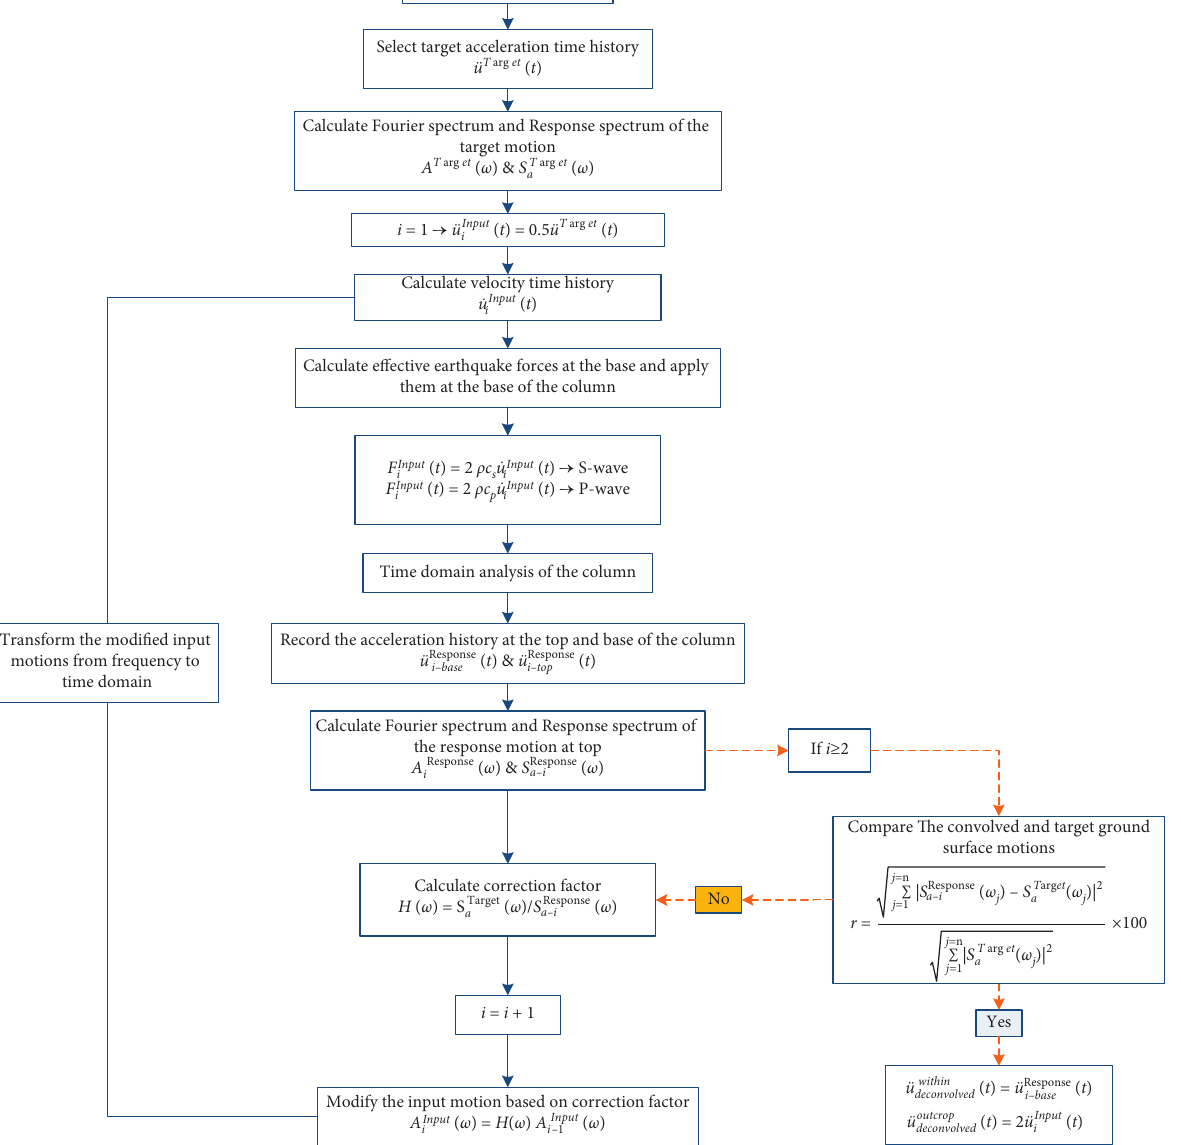
Figure 6: Deconvolution of the seismic surface ground motions using the time-domain iteration